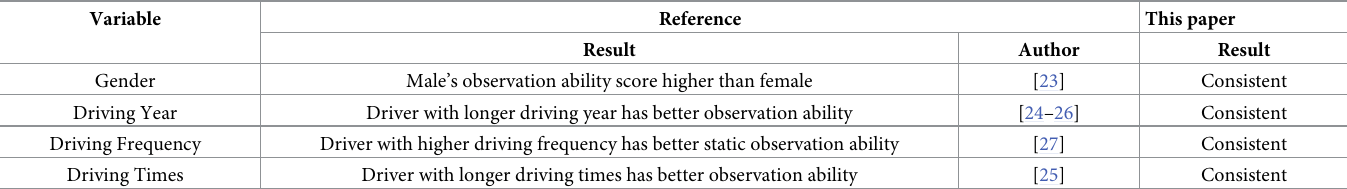
Table 10. Meta-analyses of cognitive biases of influencing factors.